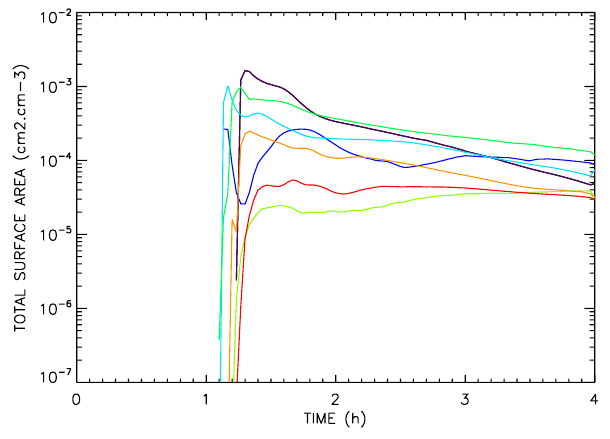
Fig. 7. Total surface area (cm 2 cm − 3 ) computed on the 7 trajecto- ries in the REF simulation.